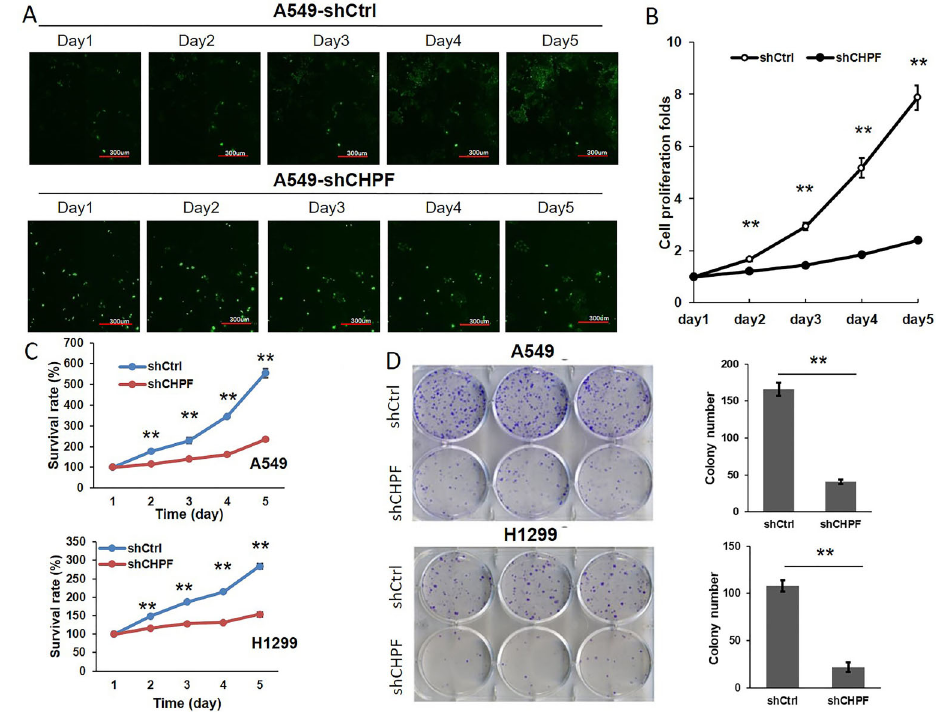
Figure 3. Effect of chondroitin polymerizing factor ( CHPF ) on the proliferation and colony formation of lung cancer cells. A and B , High- content cell imaging was used daily to assess cell growth in A549 cells following lentivirus infection (scale bar: 300 m m). C , MTTassays displaying the survival of A549 and H1299 cells after infection with sh CHPF or shCtrl for 5 days. D , Impact of CHPF silencing on the colony formation of A549 and H1299 lung cancer cells. Data are reported as means ± SD. **P o 0.01 (Student ’ s t